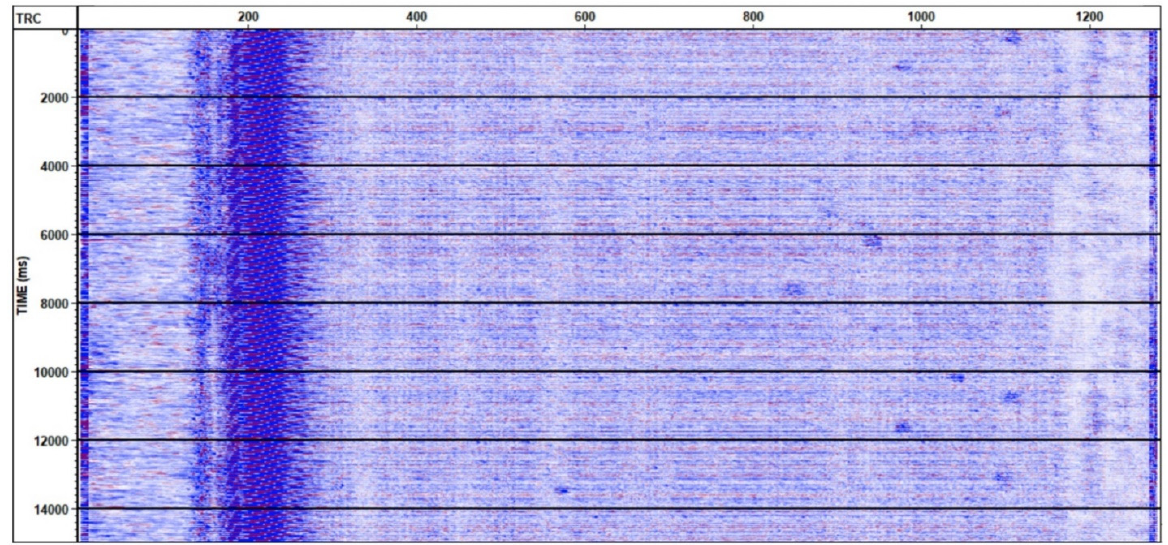
Figure 5. The results of the DAS data processing using the presented workflow.